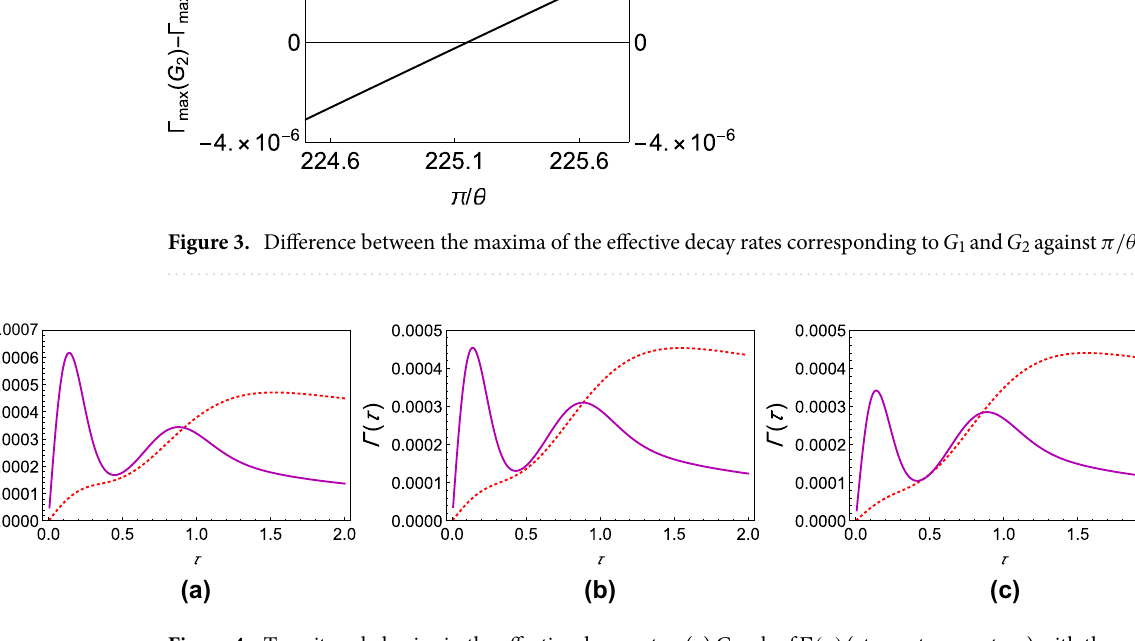
3 (dashed, red curve). ( b ) =